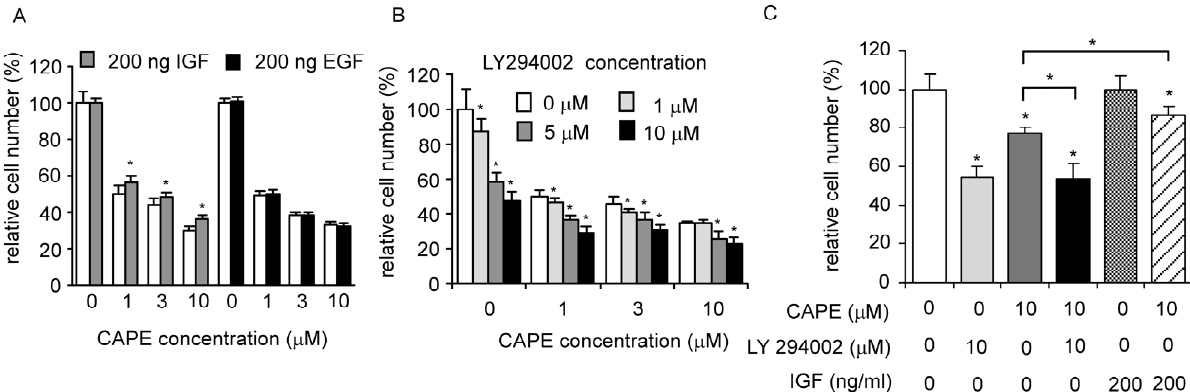
Figure 5. CAPE treatment targets PI3K/Akt signaling pathway. ( A ) LNCaP 104-S cells were treated with 0, 1, 3, or 10 μ M CAPE in the presence and absence of 200 ng IGF-1 or 200 ng EGF for 96 h; ( B ) LNCaP 104-S cells was treated with CAPE (0, 1, 3, or 10 μ M) combinations of CAPE (10 μ M), LY294002 (10 μ M), and IGF-1 (200 ng/mL) for 72